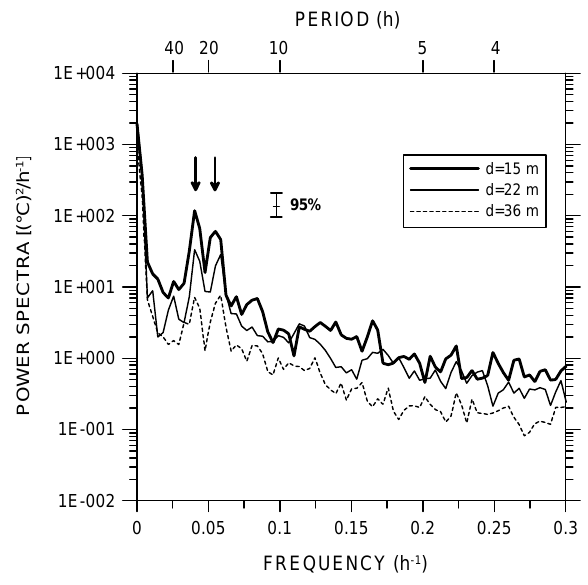
Fig. 5. Fourier power spectra of sea temperature measured at Cape Figure 5. Fourier power spectra of sea temperature measured at Cape Struga at the depths of 15, Struga at the depths of 15, 22 and 36m, for the interval extend- 22 and 36 m, for the interval extending from 24 April to 14 November 2001. The corresponding ing from 24 April to 14 November 2001. The corresponding 95% confidence interval is also shown. Left arrow indicates the K1 tidal 95% confidence interval is also shown. Left arrow indicates the K1 tidal period, right one period, right one denotes the inertial denotes the inertial period.